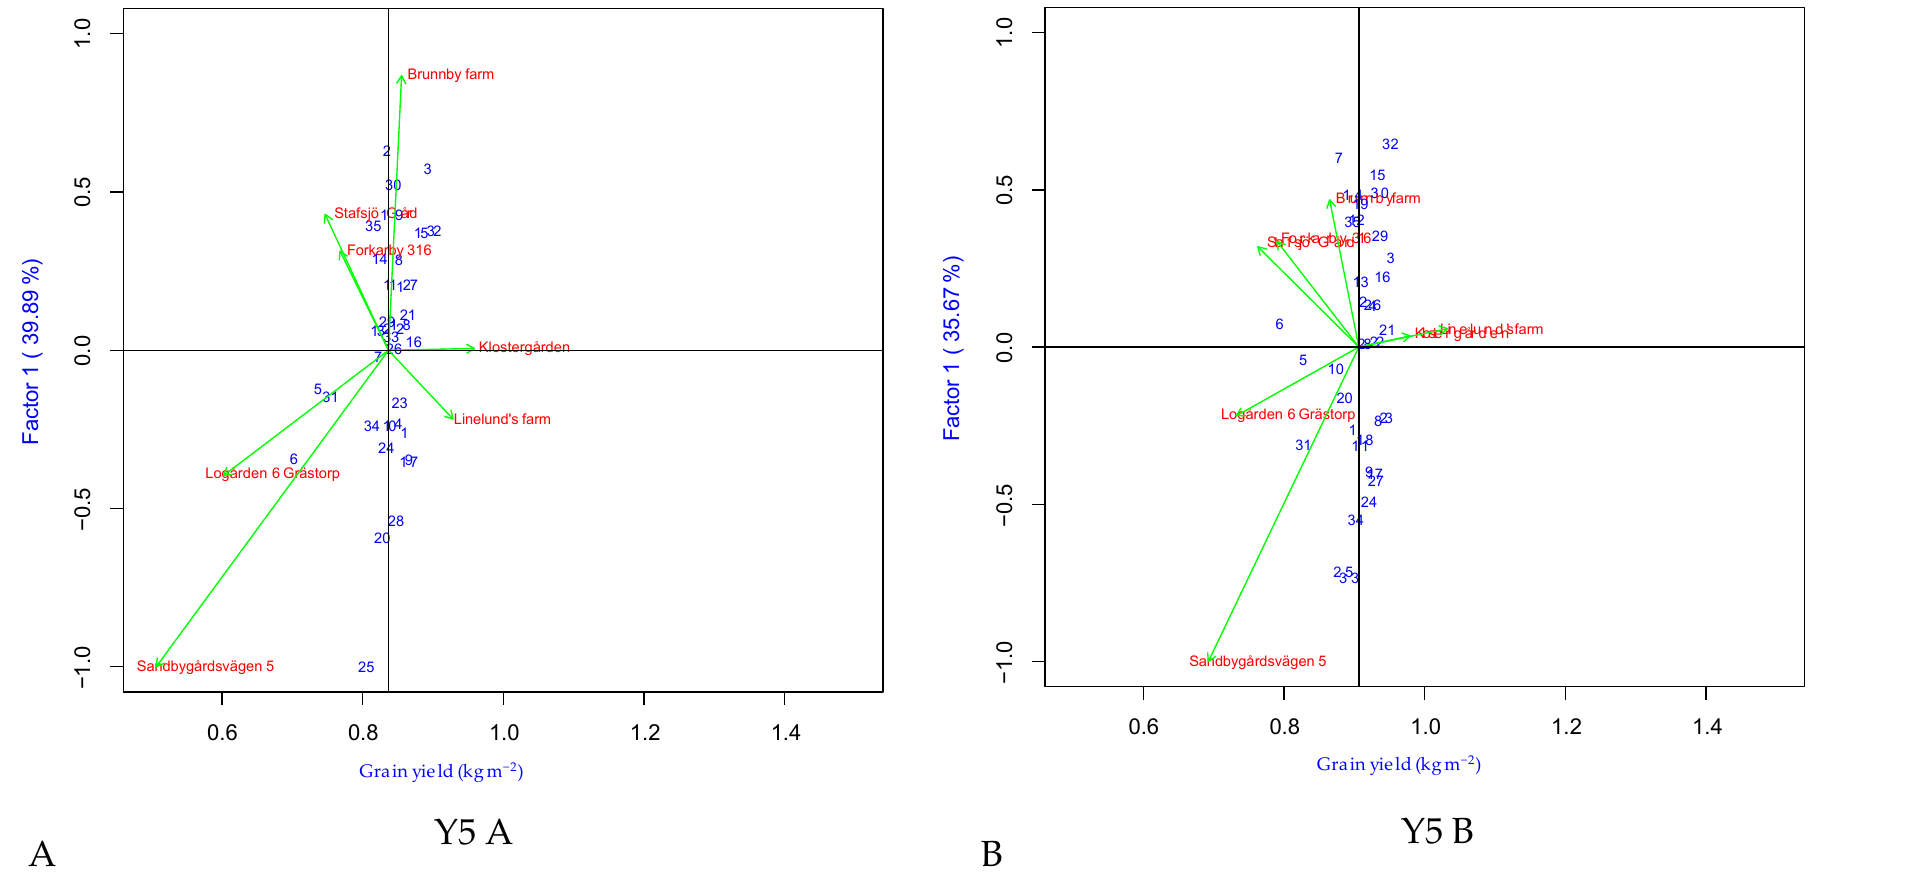
Figure 3. Plot of AMMI PCA1 scores of the grain yield (kg m − 2 ) under untreated ( A ) and treated ( B ) conditions, across five years (Y1 to Y5).